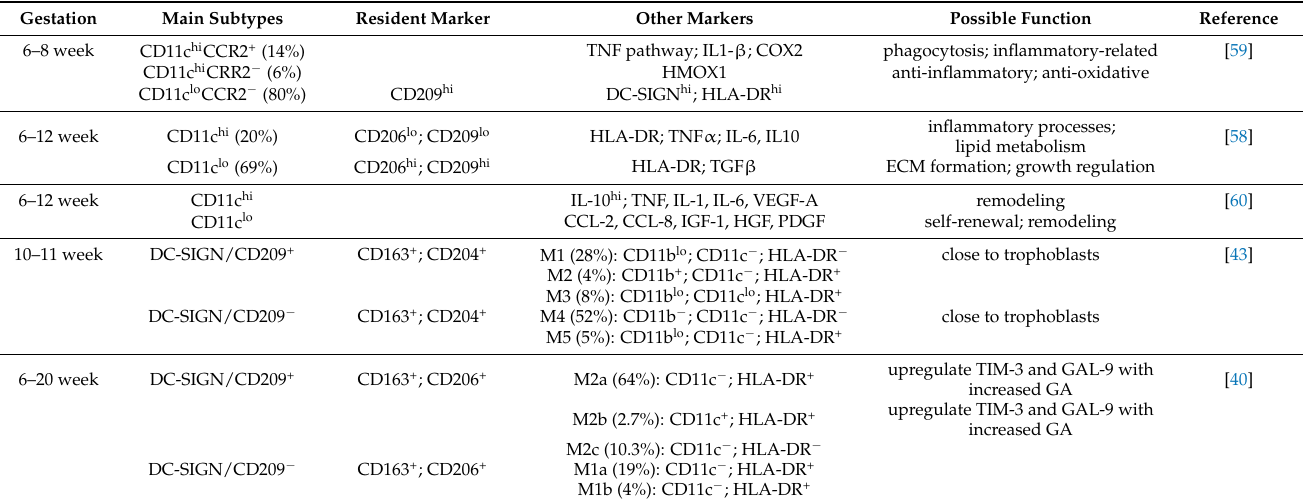
Table 1. Characteristics of macrophage subsets based on single-cell studies of macrophages in first trimester